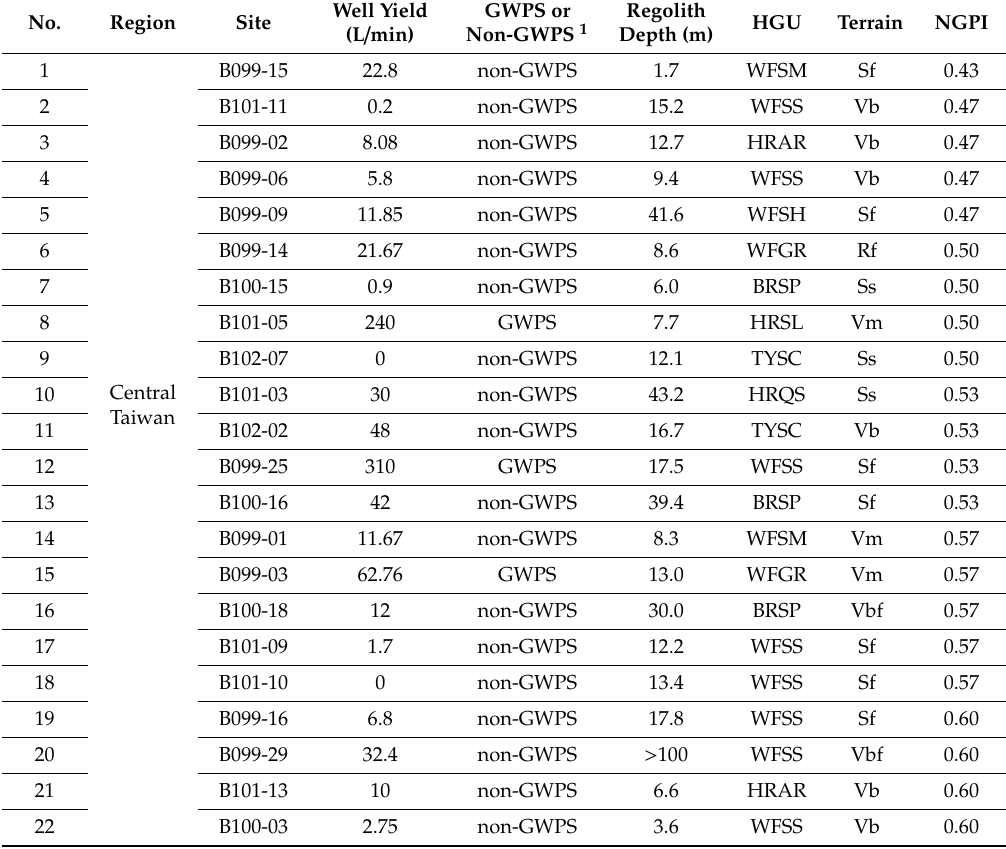
Table 4. Summarized characteristics of in-situ